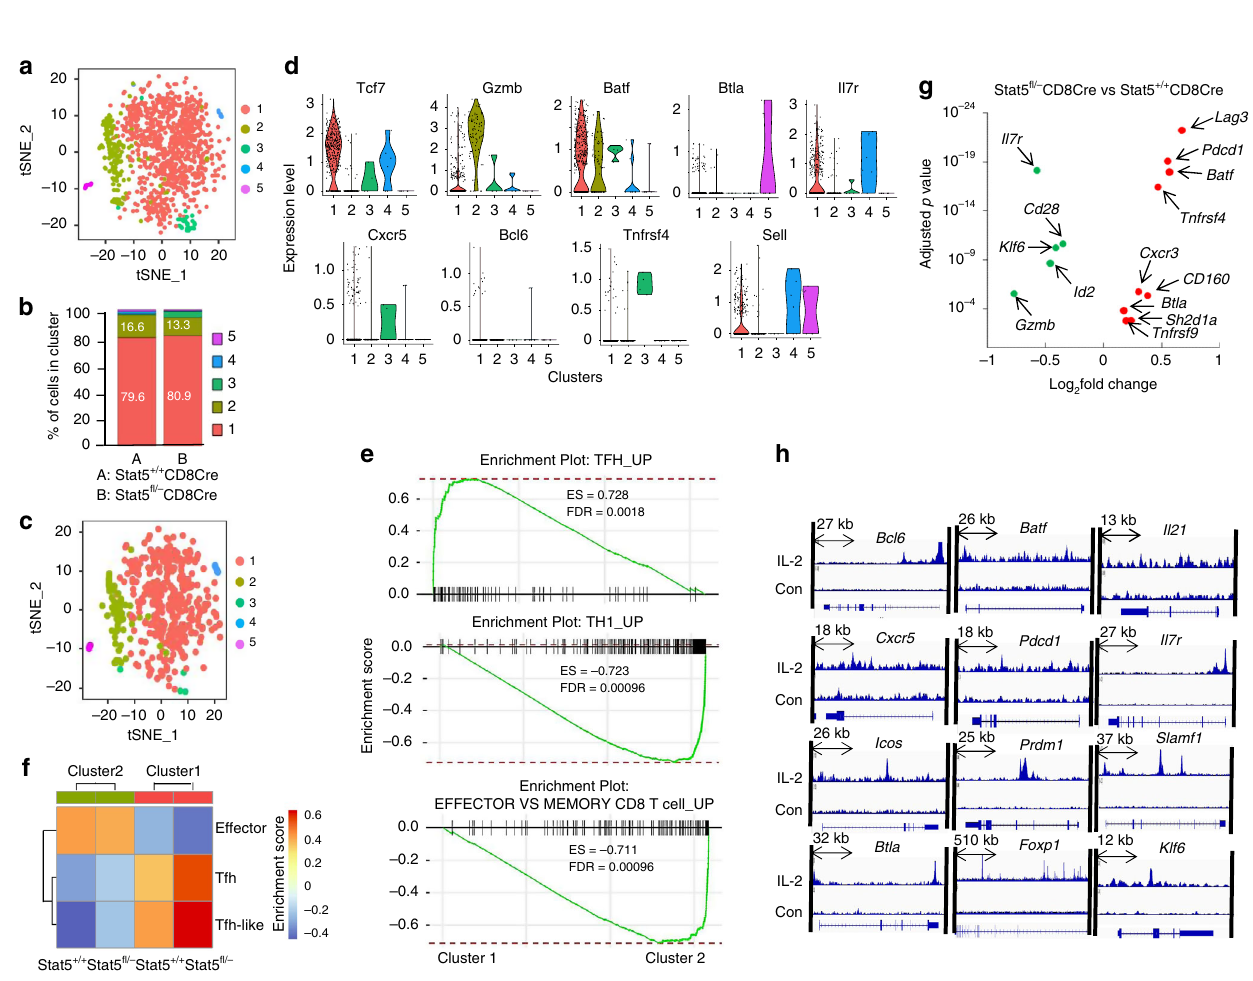
Fig. 6 Single-cell RNA-seq analysis of CXCR5 + PD-1 + CD8 + T cells. CXCR5 + PD-1 + CD8 + T cells were sorted from LCMV-infected Stat5 + / + CD8Cre/YFP or Stat5 fl / − CD8Cre/YFP mice. a t-SNE plot of cells from Stat5 + / + CD8Cre/YFP and Stat5 fl / − CD8Cre/YFP mice. Each cell is grouped into one of the fi ve clusters that are distinguished by the indicated colors. b Percentages of cells in each cluster within the total cells in all fi ve clusters. c t-SNE plot of cells from Stat5 + / + CD8Cre/ YFP mice. d Violin plot showing the distribution of the expression levels of Tcf7, Gzmb, Batf, Tnfrsf4, Sell, Il7r, Btla, Bcl6 and Cxcr5 in each clusters of CXCR5 + PD-1 + CD8 + cells from Stat5 + / + CD8CreYFP mice. e Comparative GSEA of the Tfh, Th1 or CD8 effector cell signatures in cluster 1 and cluster 2 of wild-type CXCR5 + PD-1 + CD8 + T cells. f GSVA of the Tfh, Th1 or CD8 + effector cell signatures in cluster 1 and cluster 2 of wild-type and Stat5-de fi cient CXCR5 + PD-1 + CD8 + T cells. g Differential expression of Tfh-related genes in the cluster 1 of wild-type and Stat5-de fi cient